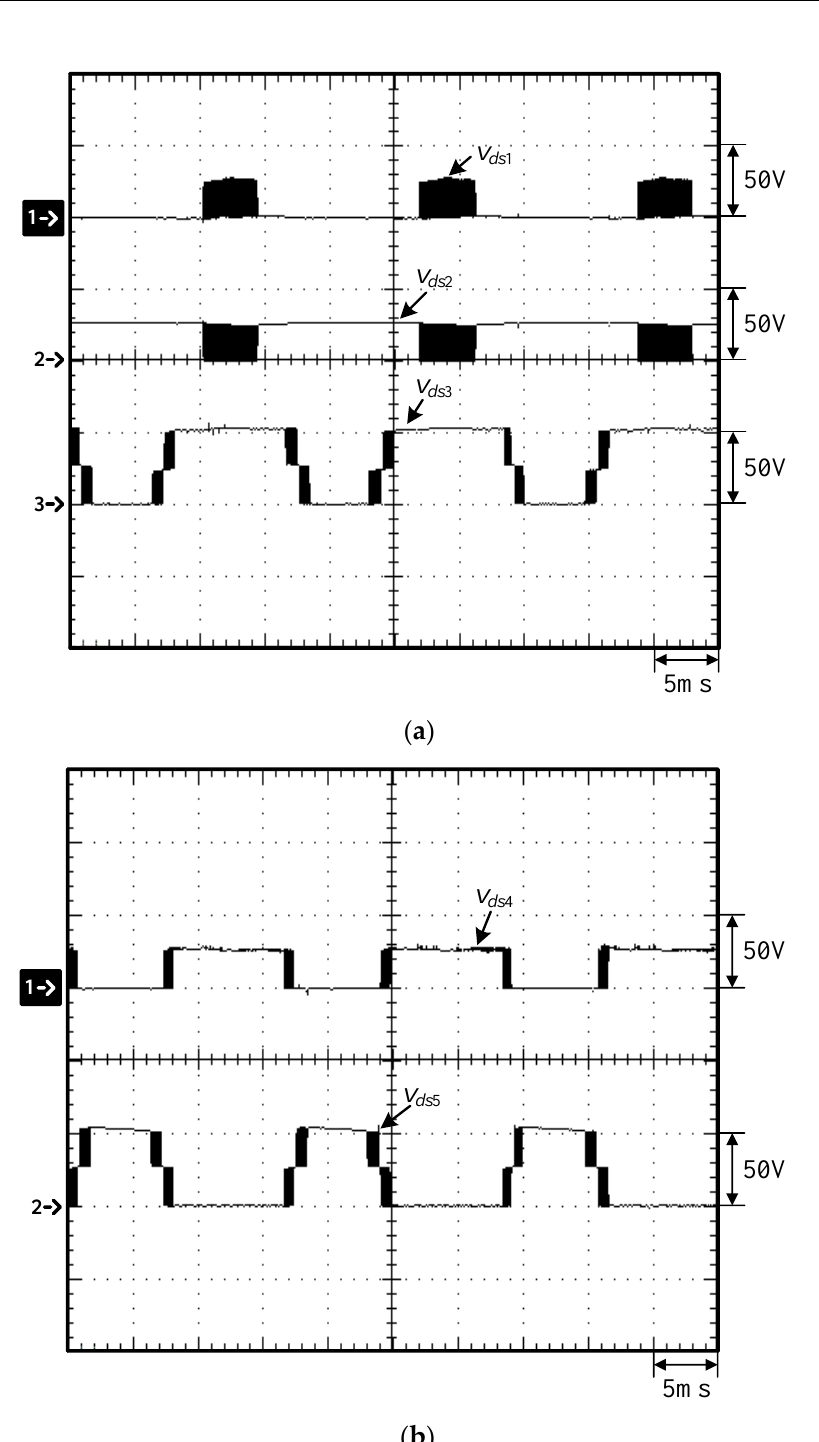
Figure18. Waveforms at rated load with (1) v C 3 and (2) v C 4 : ( a ) simulated; ( b ) measured.